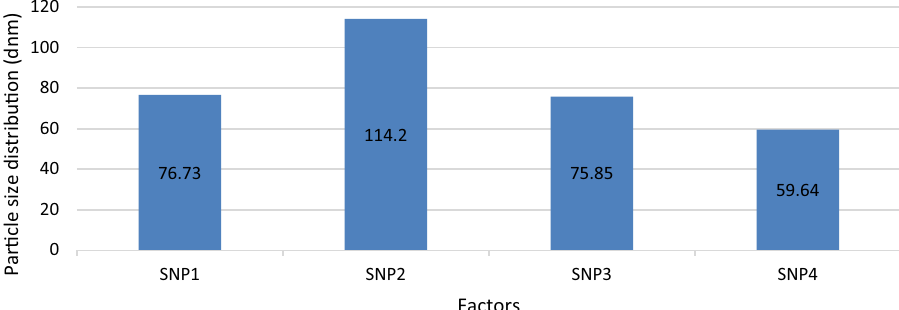
Fig. 2 Particle size diameter of the biosynthesized silver